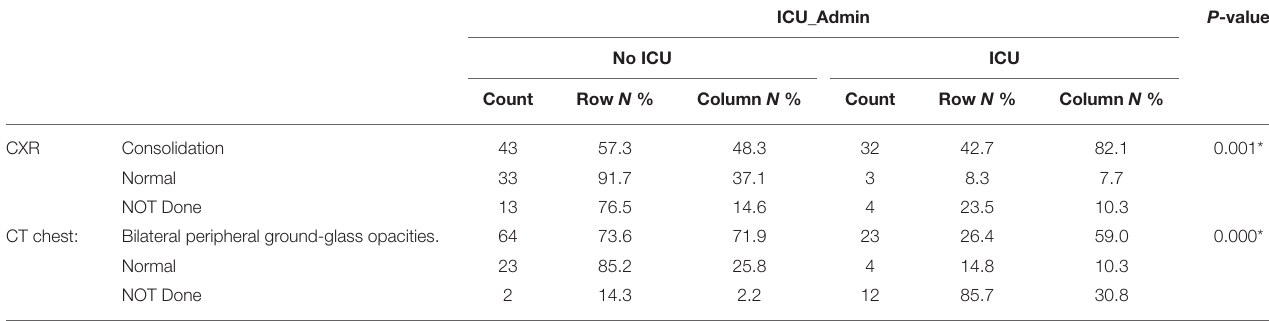
TABLE 4 | Chest X-Ray and CT Scan on admission in the training